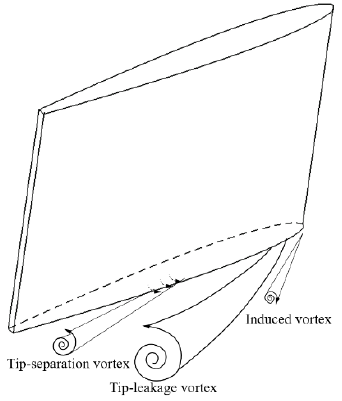
Figure 9. Illustration of the flow structures in the endwall region.